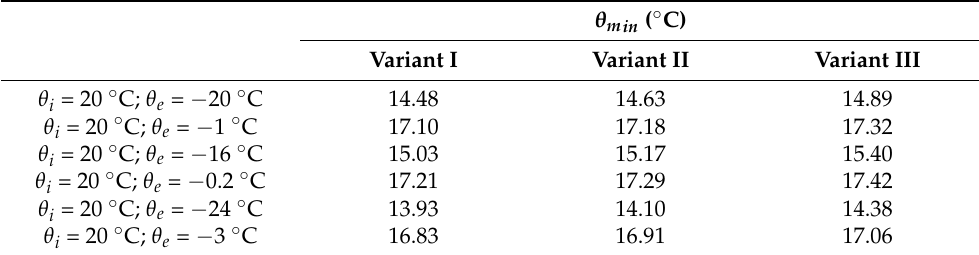
Table 15. Temperature at the junction of the external wall with the roof.